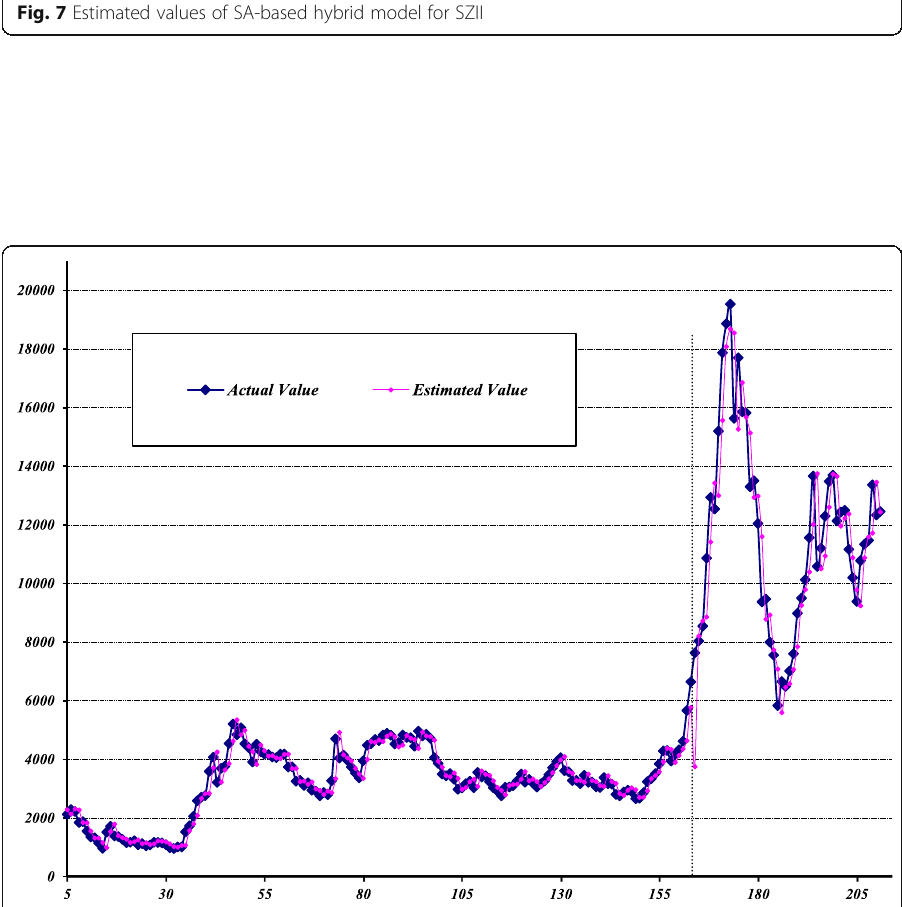
Fig. 8 Estimated values of GA-based hybrid model for SZII